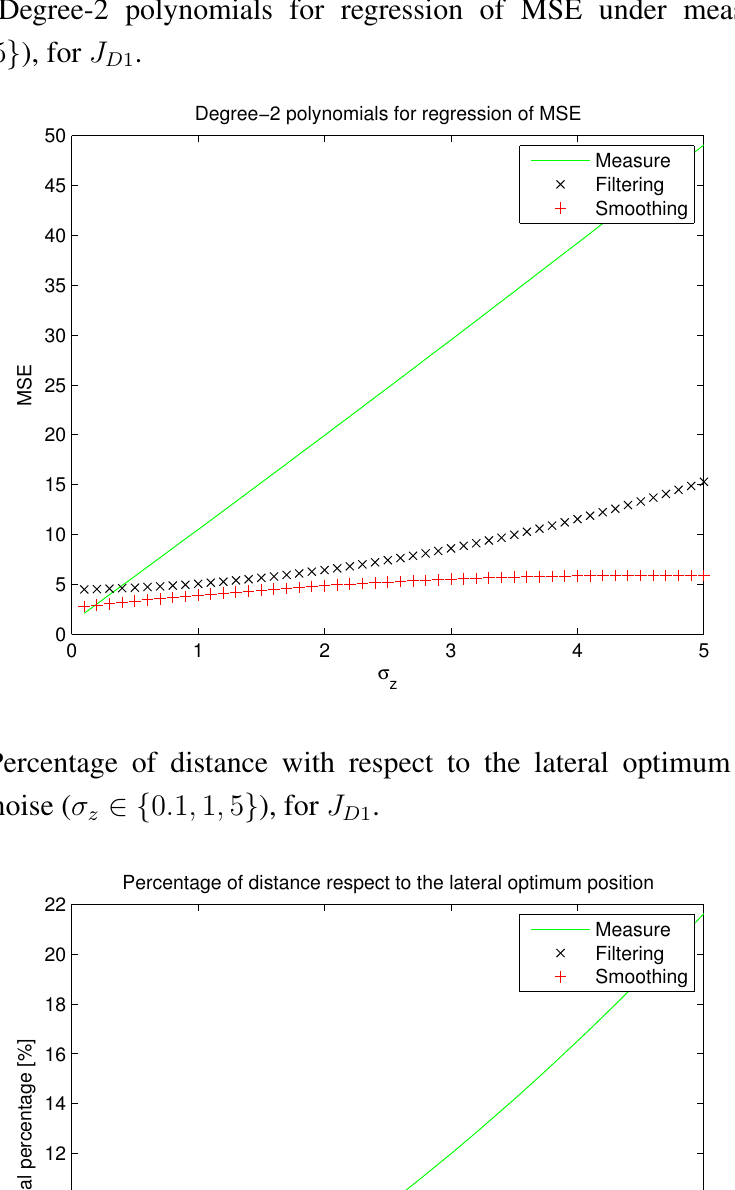
Figure 12. Degree-2 polynomials for regression of MSE under measurement noise